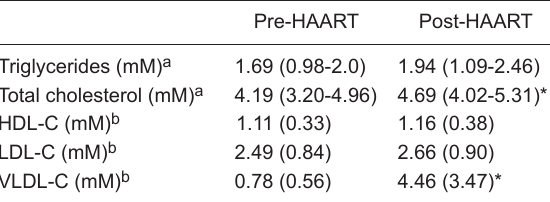
Table 2 - Pre- and post-HAART serum lipid levels (N =